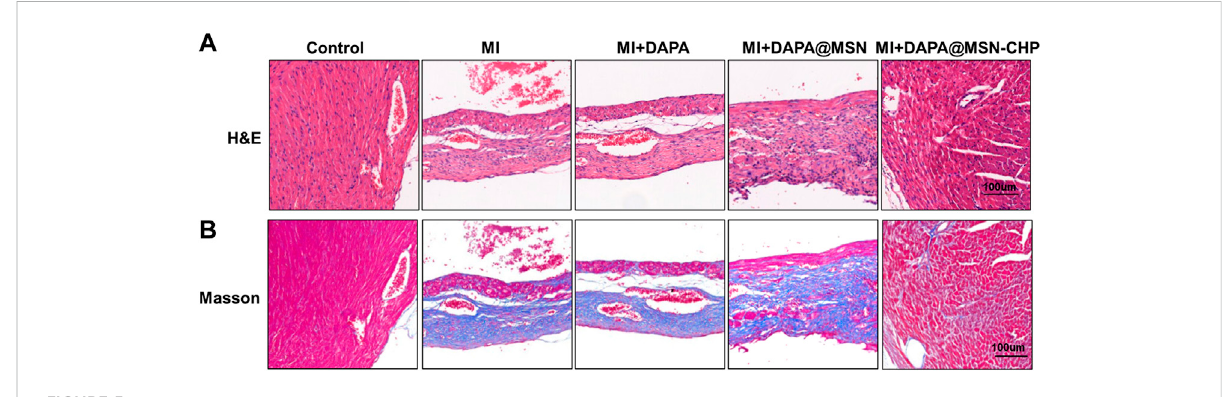
FIGURE 5 RepresentativeH&Eimages (A) Masson ’ strichromestainimages (B) ofcardiacsectionsafterMI,MI+DAPA,MI+DAPA@MSNandMI+DAPA@ MSN-CHP treatments. The healthy mice were set as